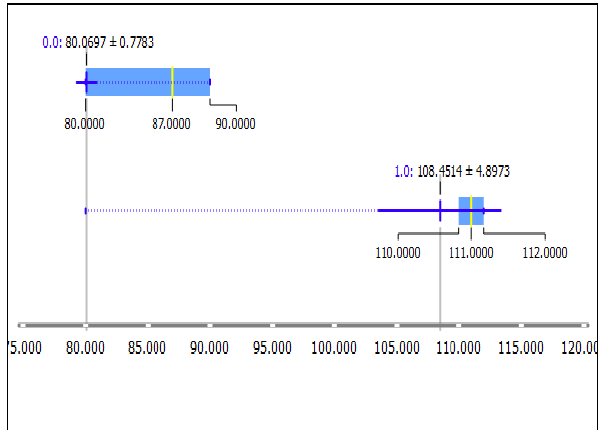
Figure 14. Data distribution of Systolic Blood Pressure SBP in a box-plot showing the range of the data, its mean value after clustering the data using the K -means clustering technique. Here, 0.0 represents the cluster for the non-hypertension class and 1.0 represents the hypertension class.